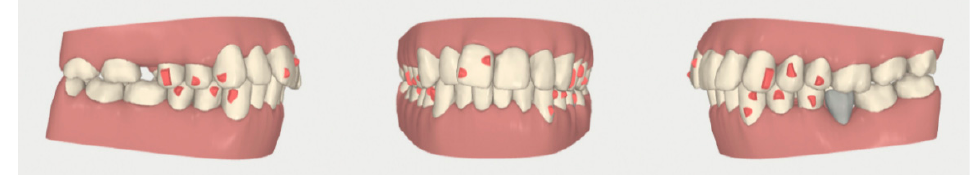
Figure 18. Case 2: initial digital frontal and lateral images showing the appropriate attachment placement for achieving the space closure.